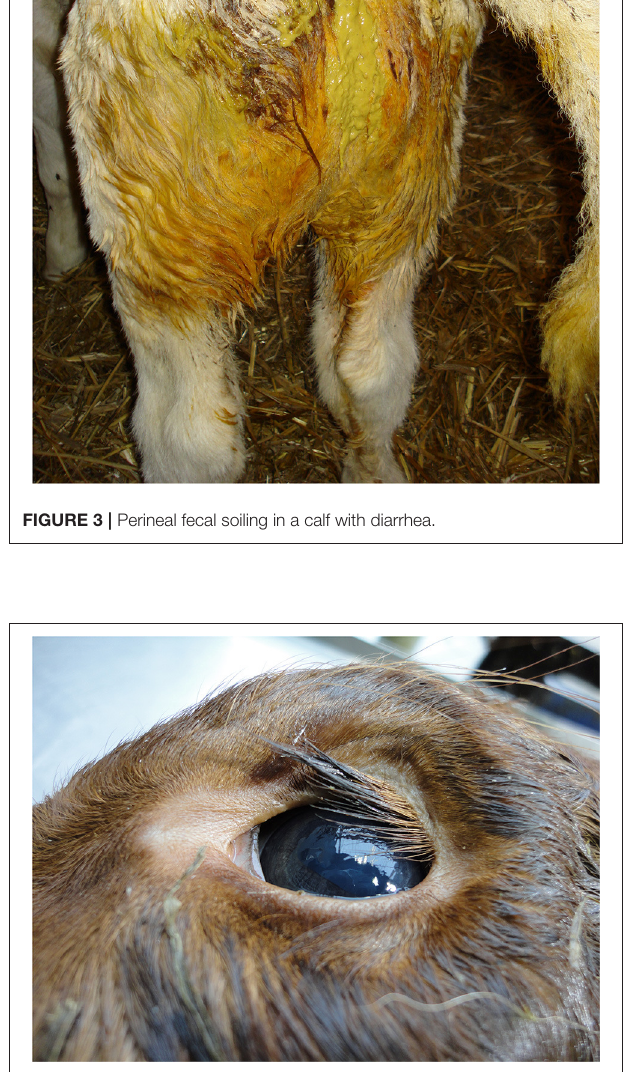
period as per (48)] or spontaneously repeatedly cough ( Figure 7 ) so the occurrence of either indicates respiratory compromise.